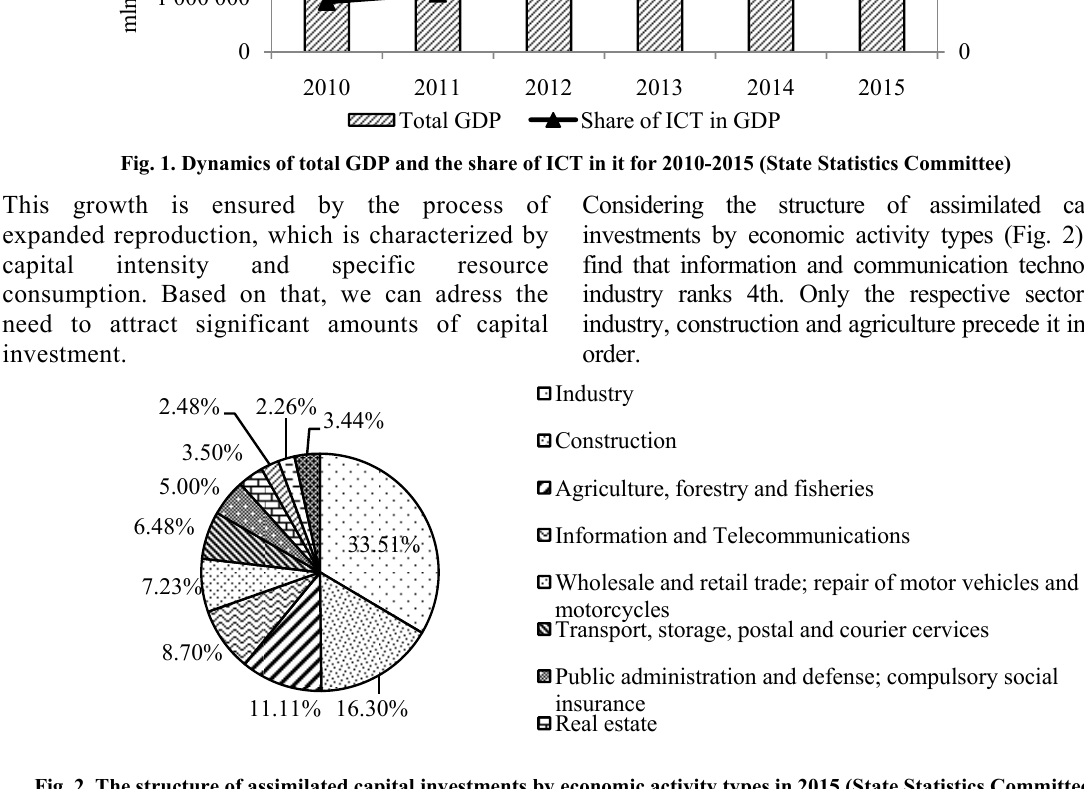
Fig. 2. The structure of assimilated capital investments by economic activity types in 2015 (State Statistics